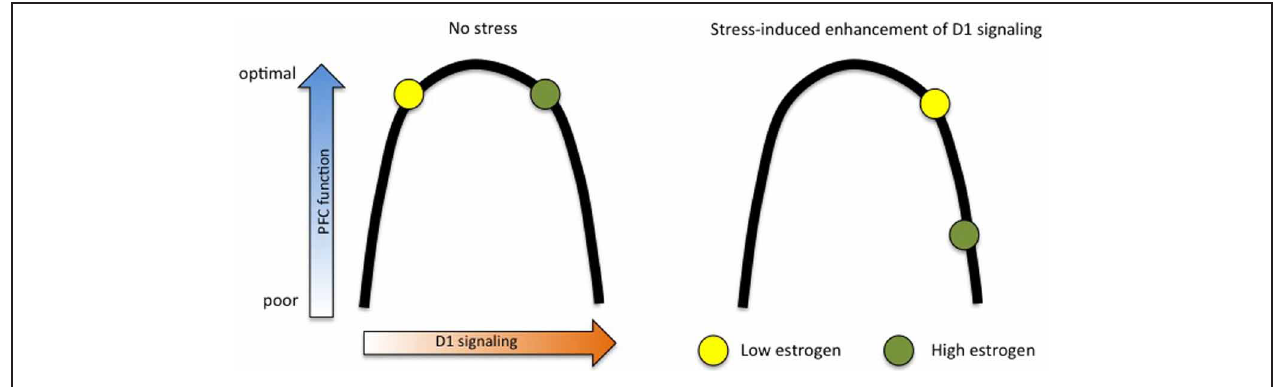
perform equally well at working memory tasks under no-stress conditions, but mild stress shifts high-estrogen animals down into the far end of the D1 inverted U, while only pushing low-estrogen animals slightly across the